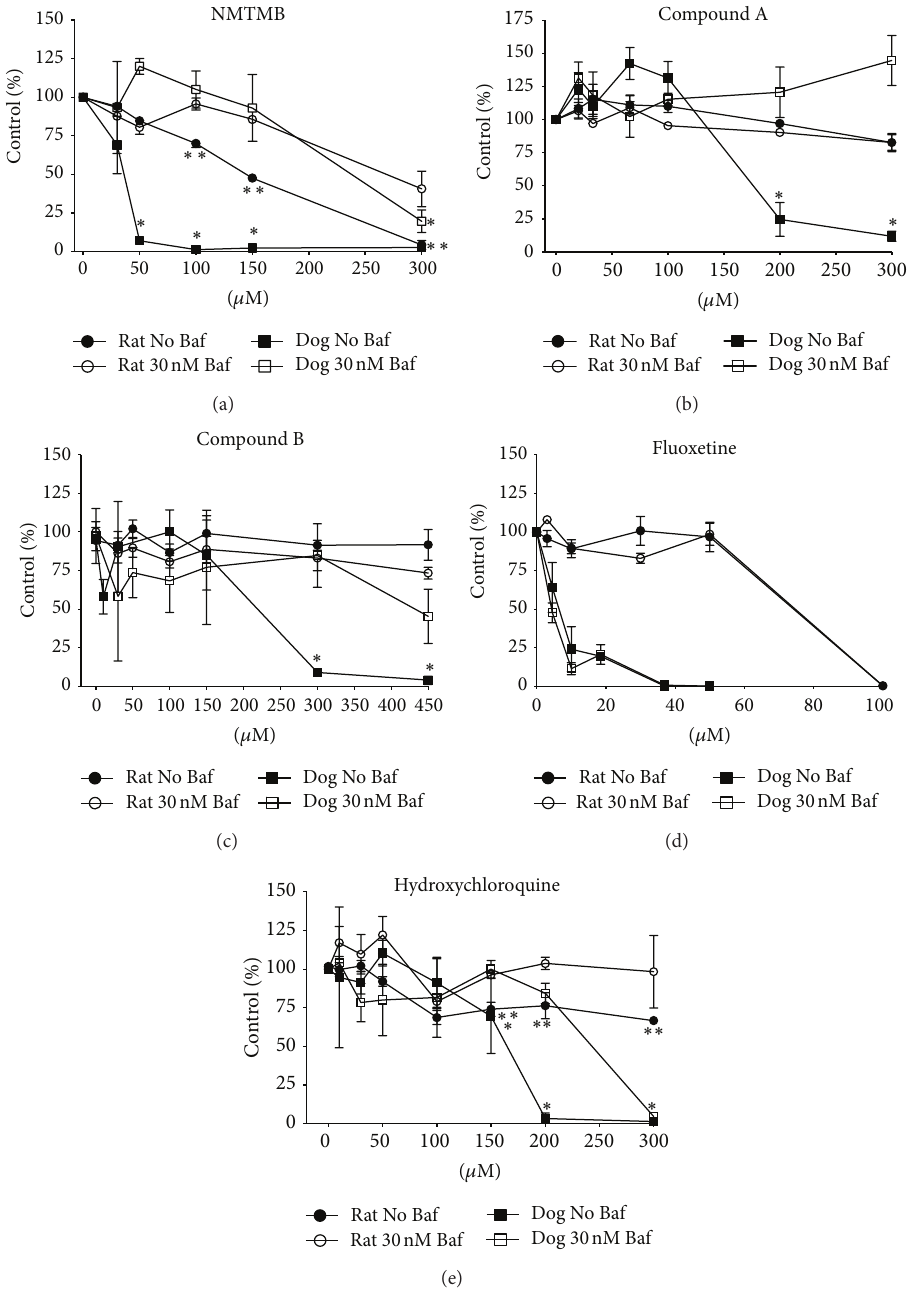
Figure 4: Effects of lysosomal modulator Baf (30nM) cotreatments on 24 h survival of phospholipogenic-treated rat and dog hepatocytes. CellsurvivalwasmeasuredusingtheCellomicsArrayscan(seeSection2).Thedataareexpressedasanaverageof3replicates( ± SD)forasingle cell isolate. Statistically significant ( 𝑃 < 0.05 , 𝑡 -test) differences between dog phospholipogenic controls and modulator treatments occurred at the four top concentrations for NMTMB, top three concentrations for hydroxychloroquine, and top 2 concentrations for compounds A and B, and are illustrated by “ ∗ ”. For rat, statistically significant differences between phospholipogenic control and modulator treatments occurred at the top 3 concentrations for NMTMB and hydroxychloroquine and are illustrated by “ ∗∗